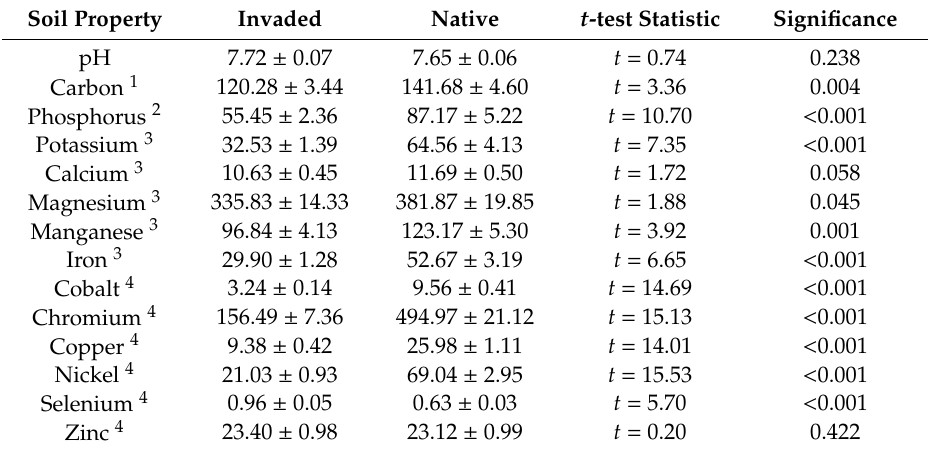
Table 1. The chemical properties of Guam cobbly clay soils within invaded mature stands of. Vitex parviflora and in adjacent native forest in central Guam. Means ± SE, n = 6. t- test